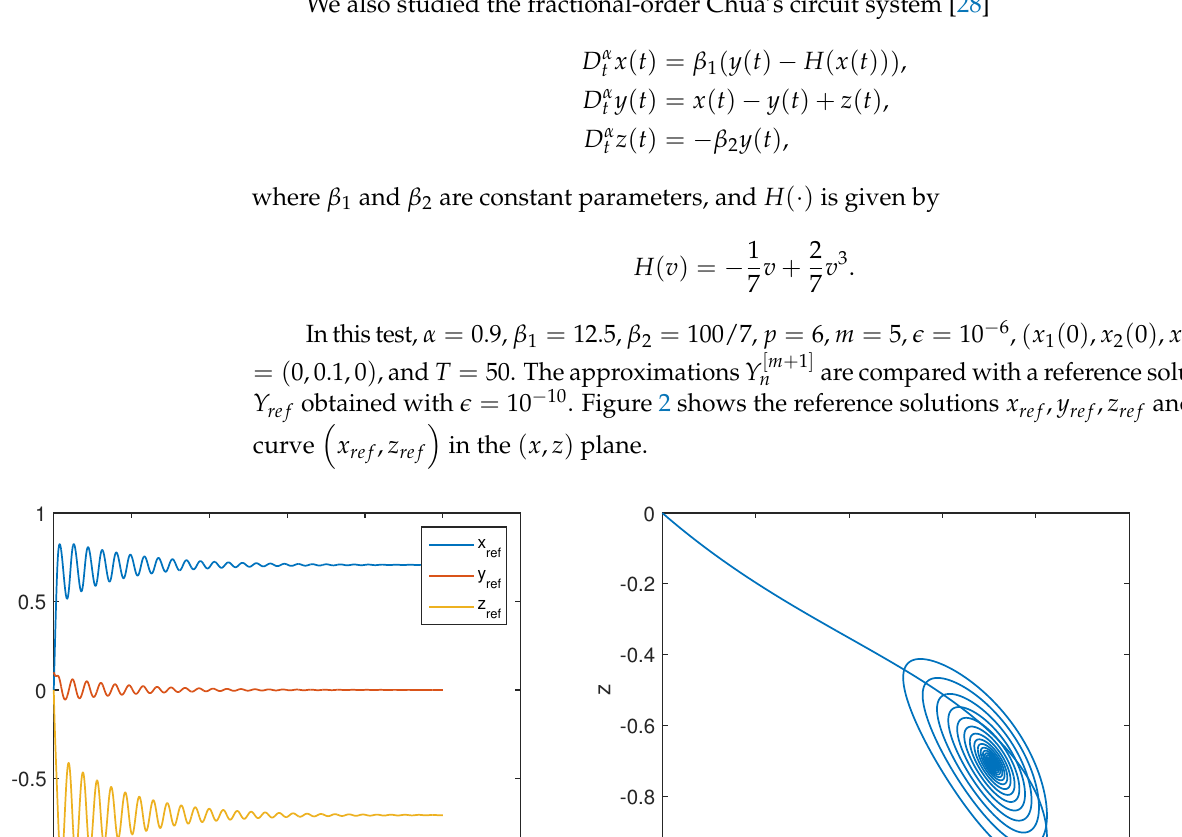
Figure 2. Chua’s circuit: ( left )—solution plot; ( right )—the curve In Figure 3, the accuracy is plotted as a function of the average time-step h avg